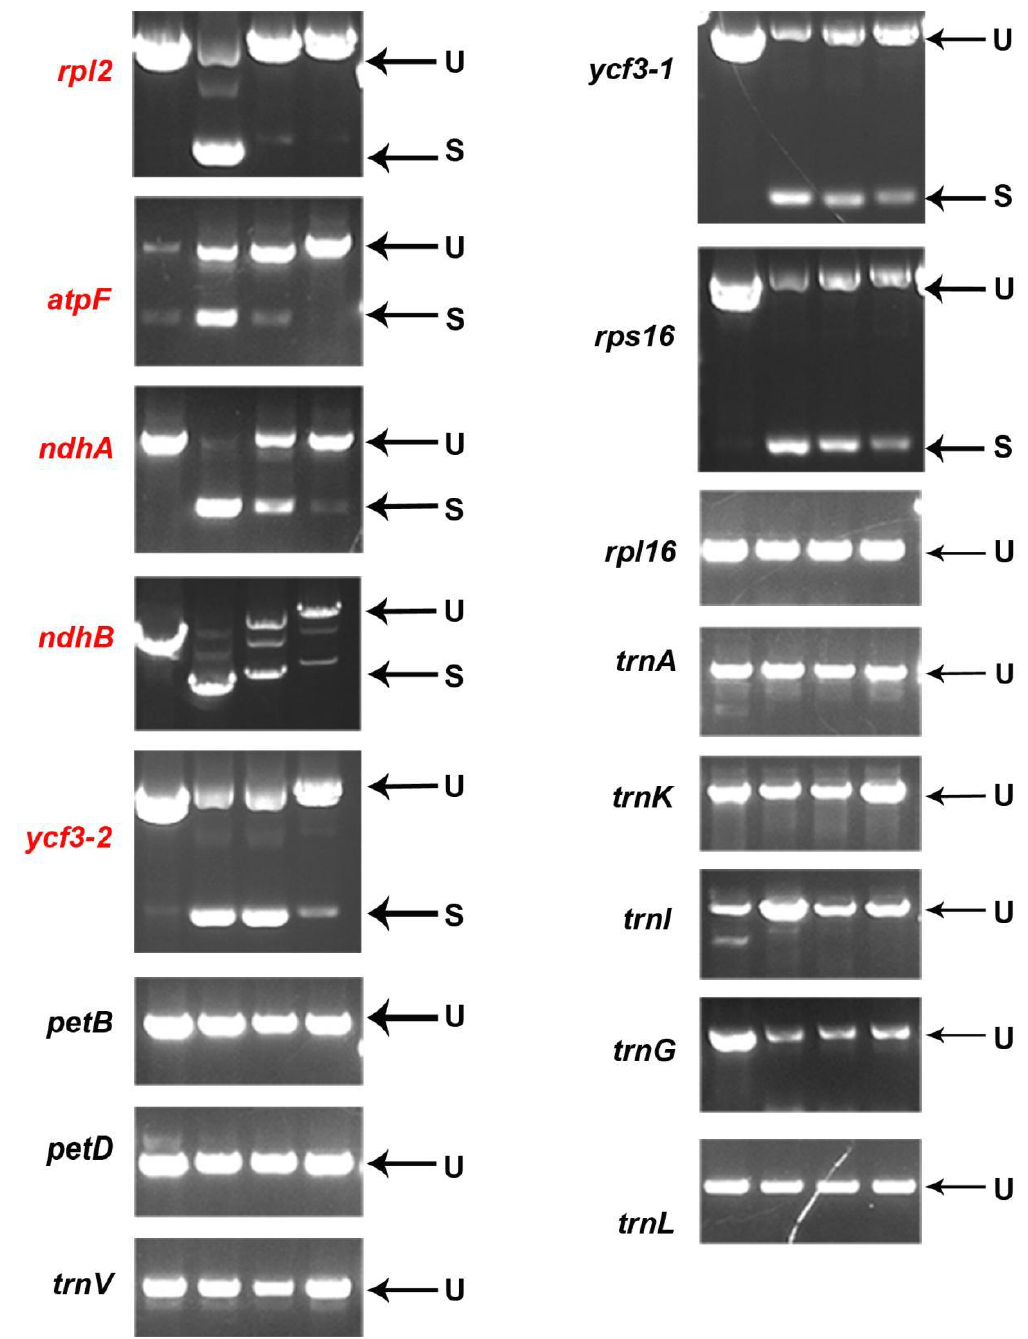
Figure 8. Splicing analysis of chloroplast transcripts in WT and mutants. From left to right, the template is DNA of WT, cDNA of WT, cDNA of as-81647 , and cDNA of ems4-05741c . S, spliced; U, unspliced. The genes marked in red are genes